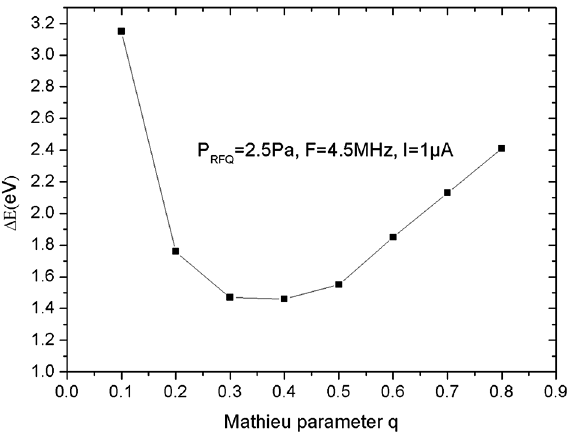
FIG. 6. Effect of the rf voltage amplitude on the longitudinal energy spread Δ E for 1 μ A ion beam: variation of Δ E as a function of Mathieu parameter